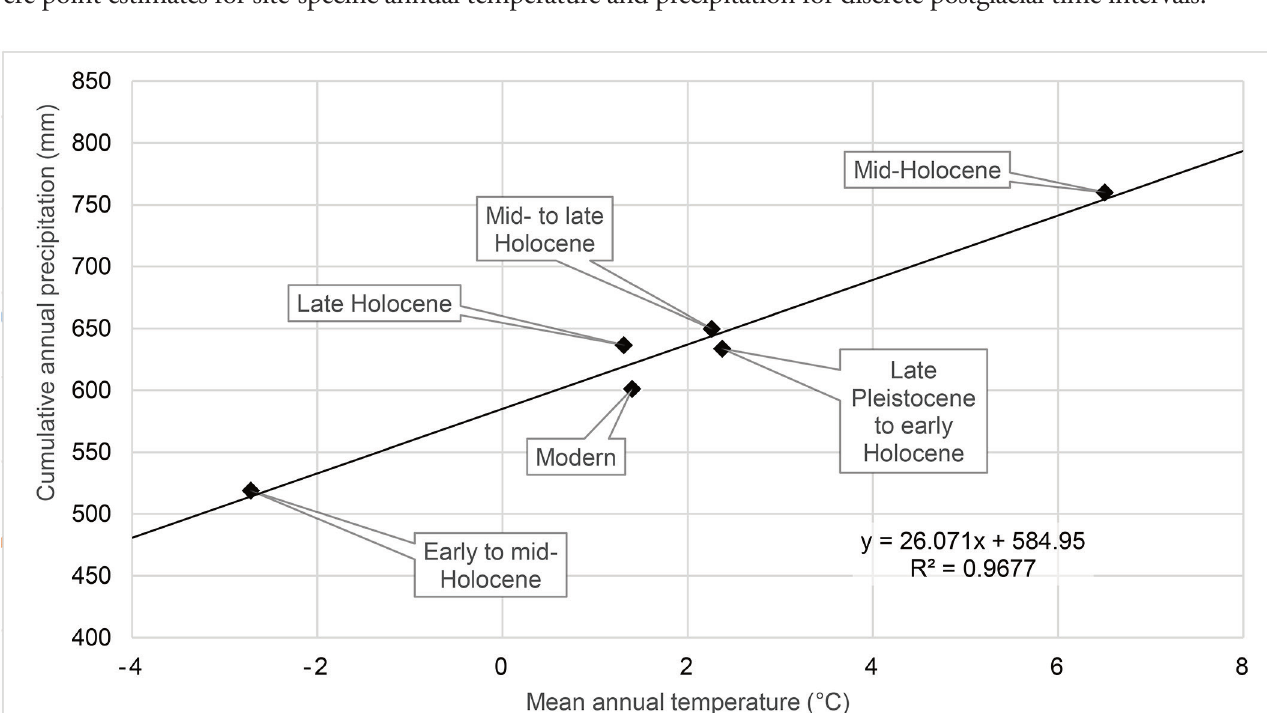
Figure 1. Reconstructed climate at riparian sites in southwestern Alberta for six intervals. Trendline plotted is equivalent to the trend from which divergence is measured in Figure